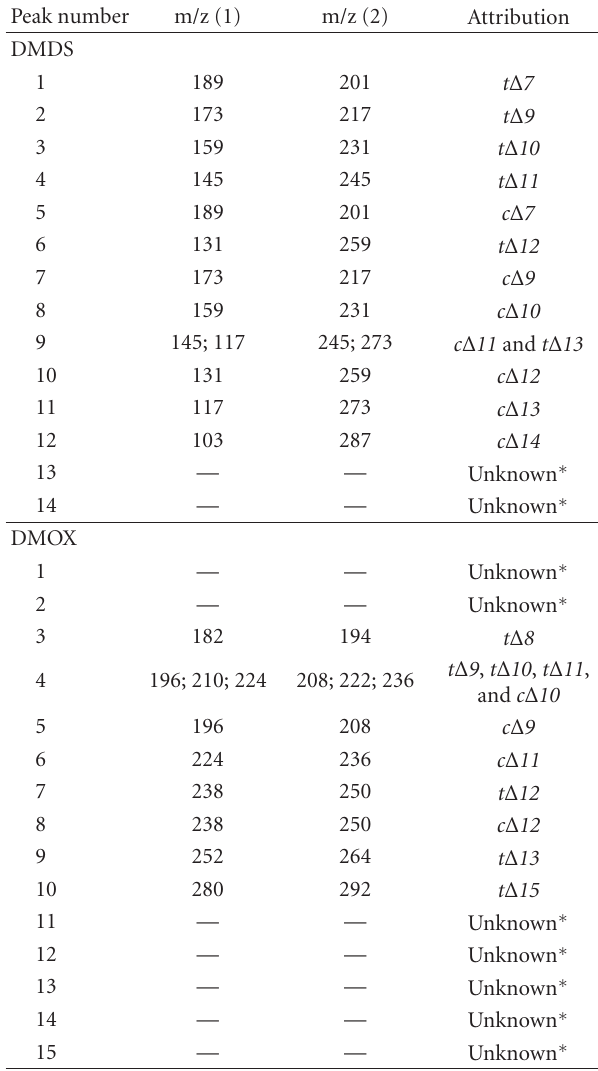
Table 2: Identification of the di ff erent C18:1 isomers by GC-MS. Cis and trans orientations were determined by comparison with commercial